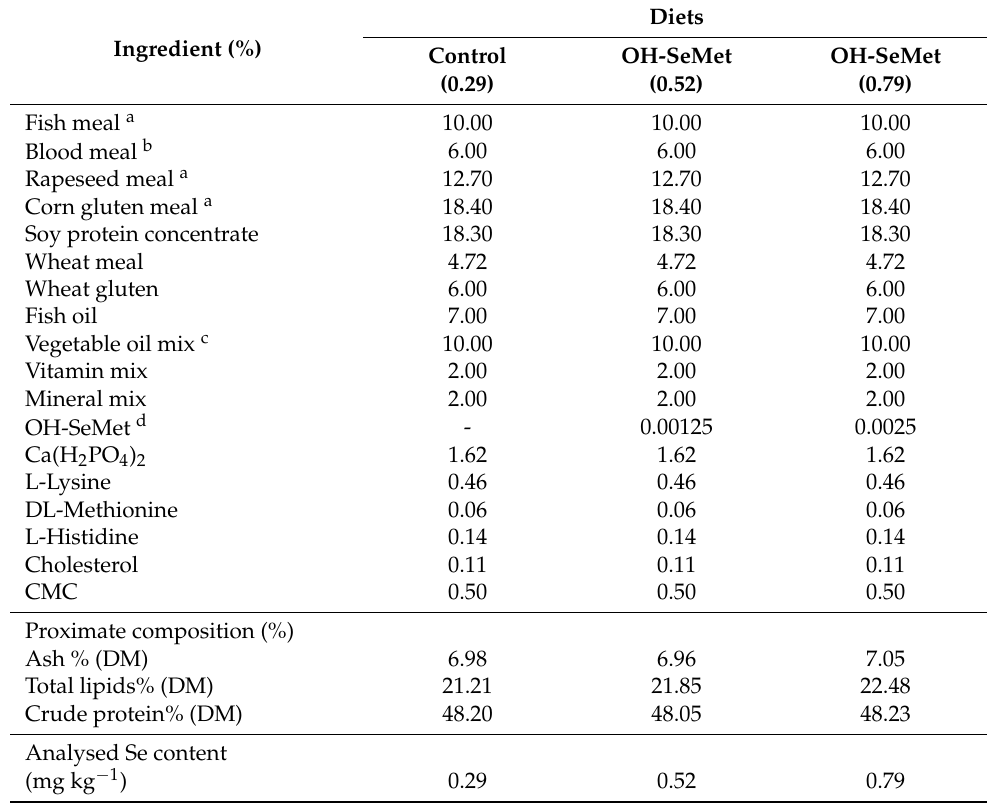
Table 1. Ingredients and proximate composition of the experimental diets containing different Se